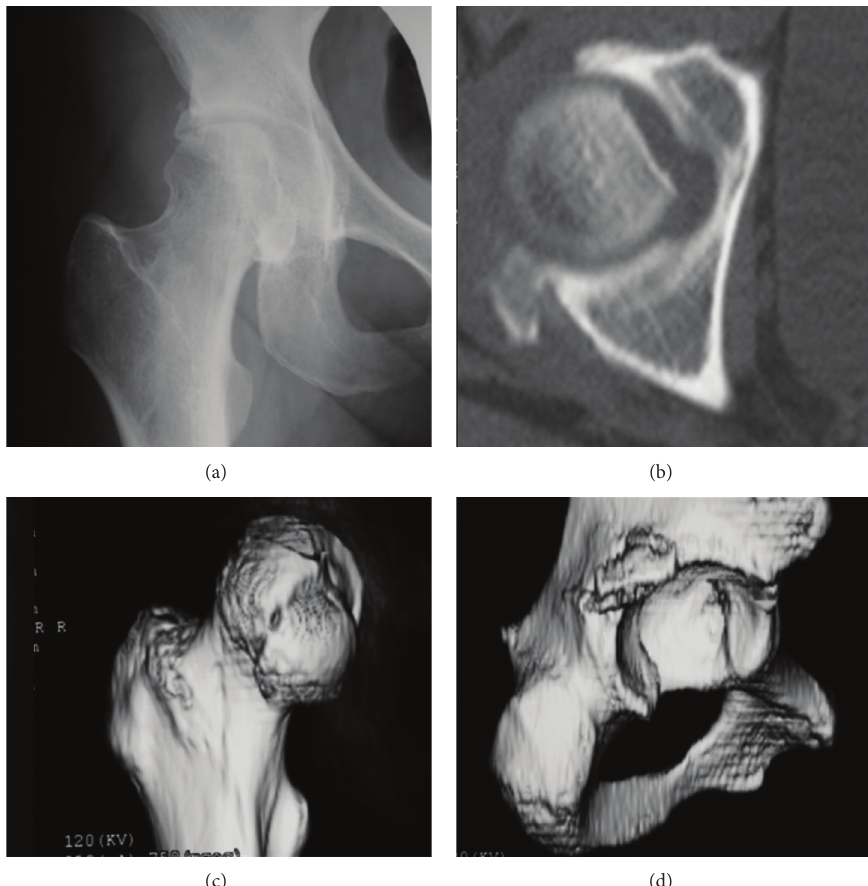
Figure 6: Case 2. A 45-year-old woman with Pipkin type-IV fracture of the right hip with posterior dislocation of the femoral head. (a) Anteroposterior X-ray image of the right hip after closed reduction, (b) axial computed tomography showing a defect of the femoral head and posterior wall of the acetabulum. (c) Three-dimensional image of the femur revealing displacement of a medial fragment of the femoral head. (d) Three-dimensional image of the acetabulum showing displacement of posterosuperior